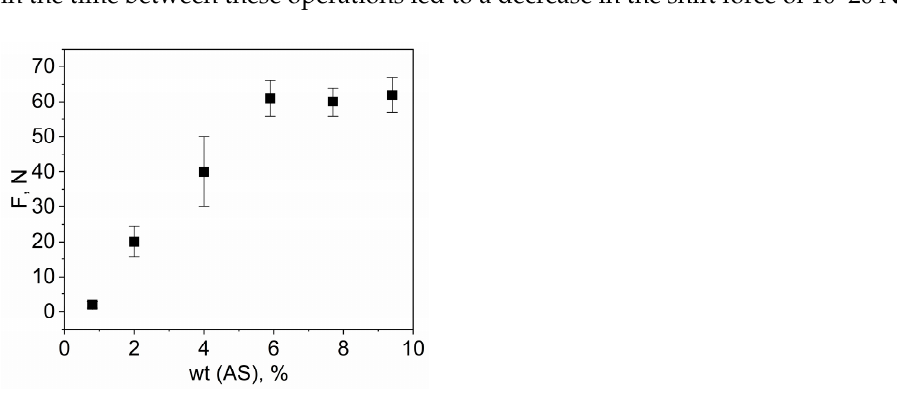
Figure 4. Dependence of ( A ) Shore hardness (type D), ( B ) max stress, and ( C ) elasticity on the ratio of allyl groups in the OSTE-MS prepolymers.